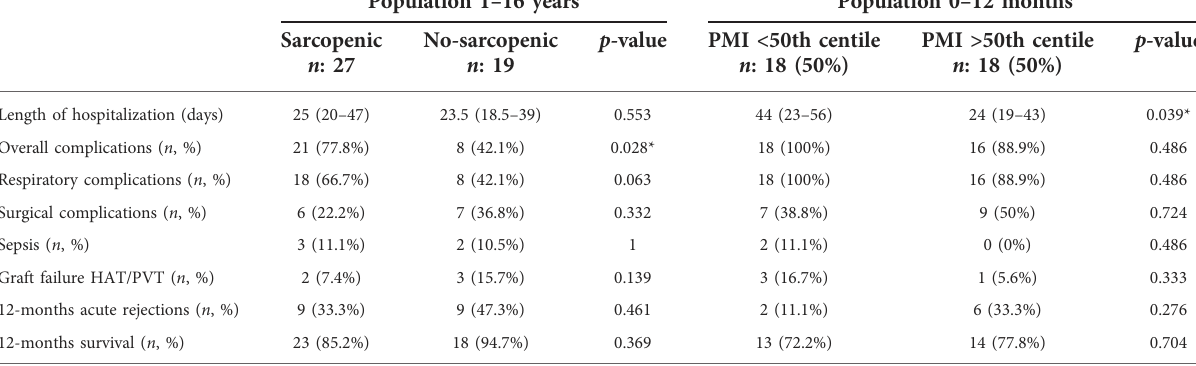
TABLE 4 Liver transplant-related complications in sarcopenic and non-sarcopenic